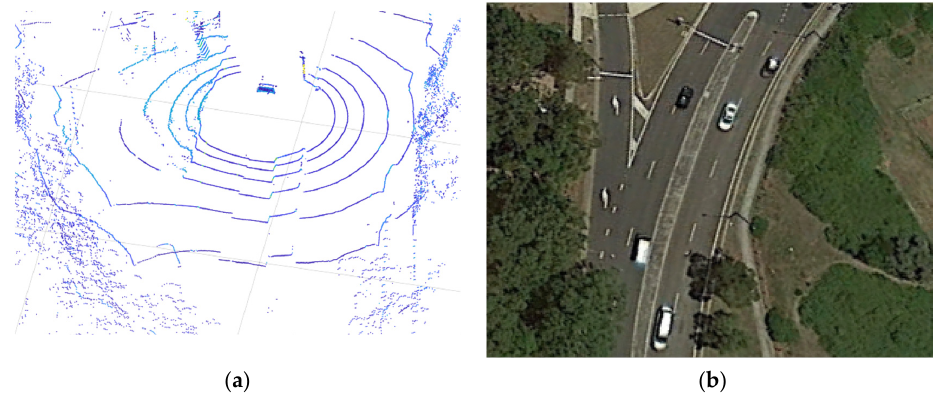
Figure 18. Scan frame at epoch 40,854 s with big outlier in Trajectory Section 2: a following vehicle is driving to another road, ( a ) Lidar scan; ( b ) Google Earth view.